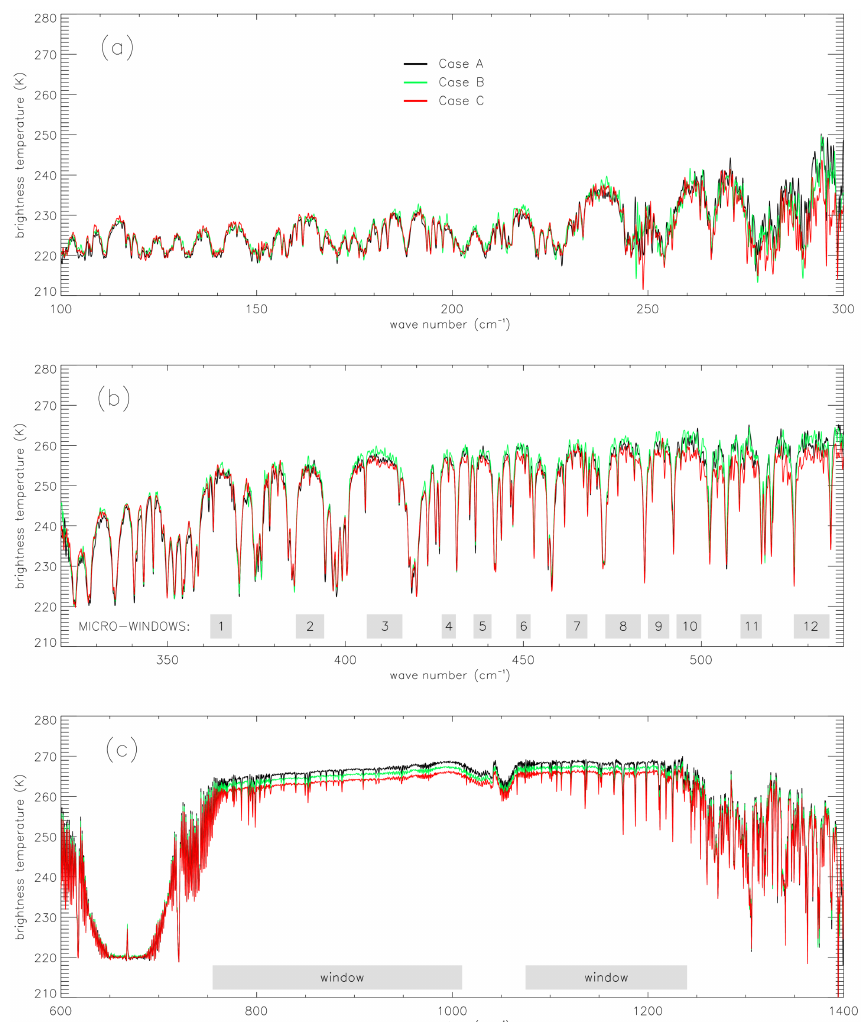
Figure 2. Brightness temperature spectra for the cases A–C. (a) Individual TAFTS LW channel spectra. (b) Individual TAFTS SW channel spectra. (c) For each case, the mean of eight ARIES individual radiance spectra, converted to equivalent brightness temperature spectra, is shown. Also shown are (b) a selection of atmospheric micro-window regions and (c) the two main window